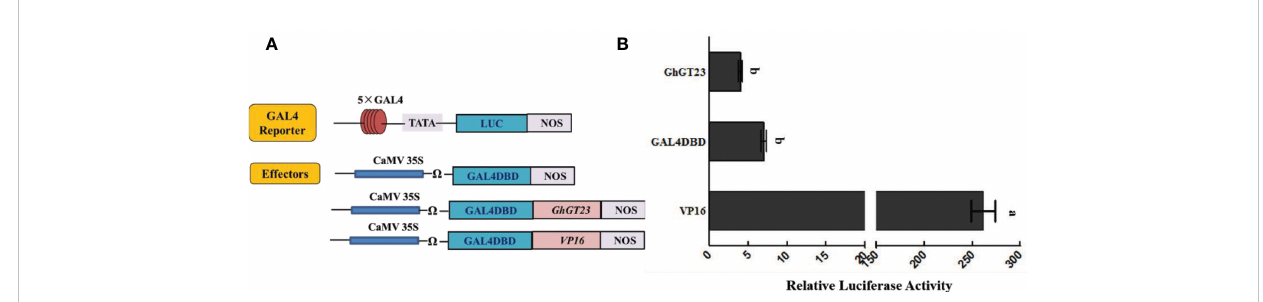
FIGURE 11 Assessing the transcriptional activity of GhGT23 with a dual-luciferase reporter assay. (A) Diagram of the reporter and effector constructs used in the dual-luciferase reporter assay to assess the transcriptional activity of GhGT23 . The GAL4 reporter was co-transfected with Renilla luciferase and each of the three effectors. (B) Luminescence from luciferase was quanti fi ed to assess the transcriptional activity of GhGT23 . Each bar represents the average of three experiments. Error bars indicate standard deviation and different letters indicate signi fi cant differences (p < 0.05) which were determined using ANOVA, followed by Duncan ’ s multiple comparison test.